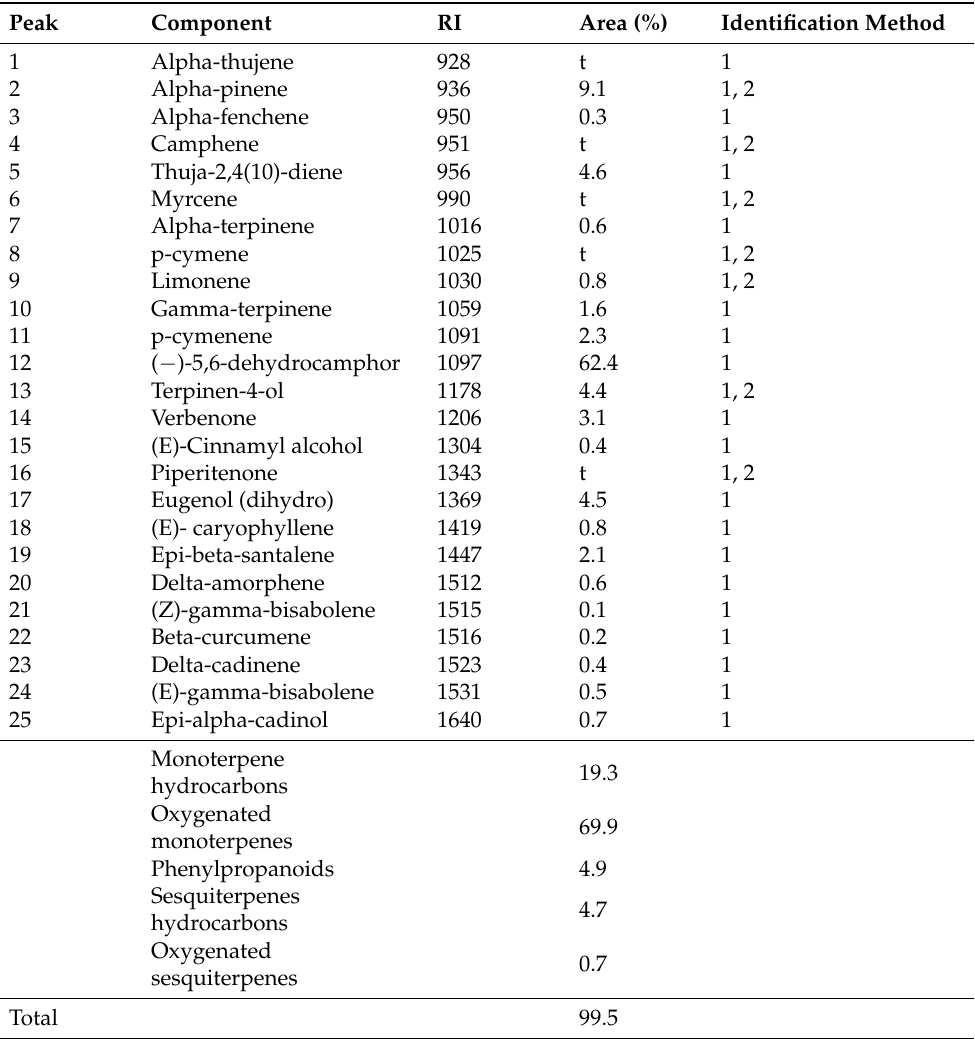
Table 1. Chemical composition of the Zuccagnia punctata essential